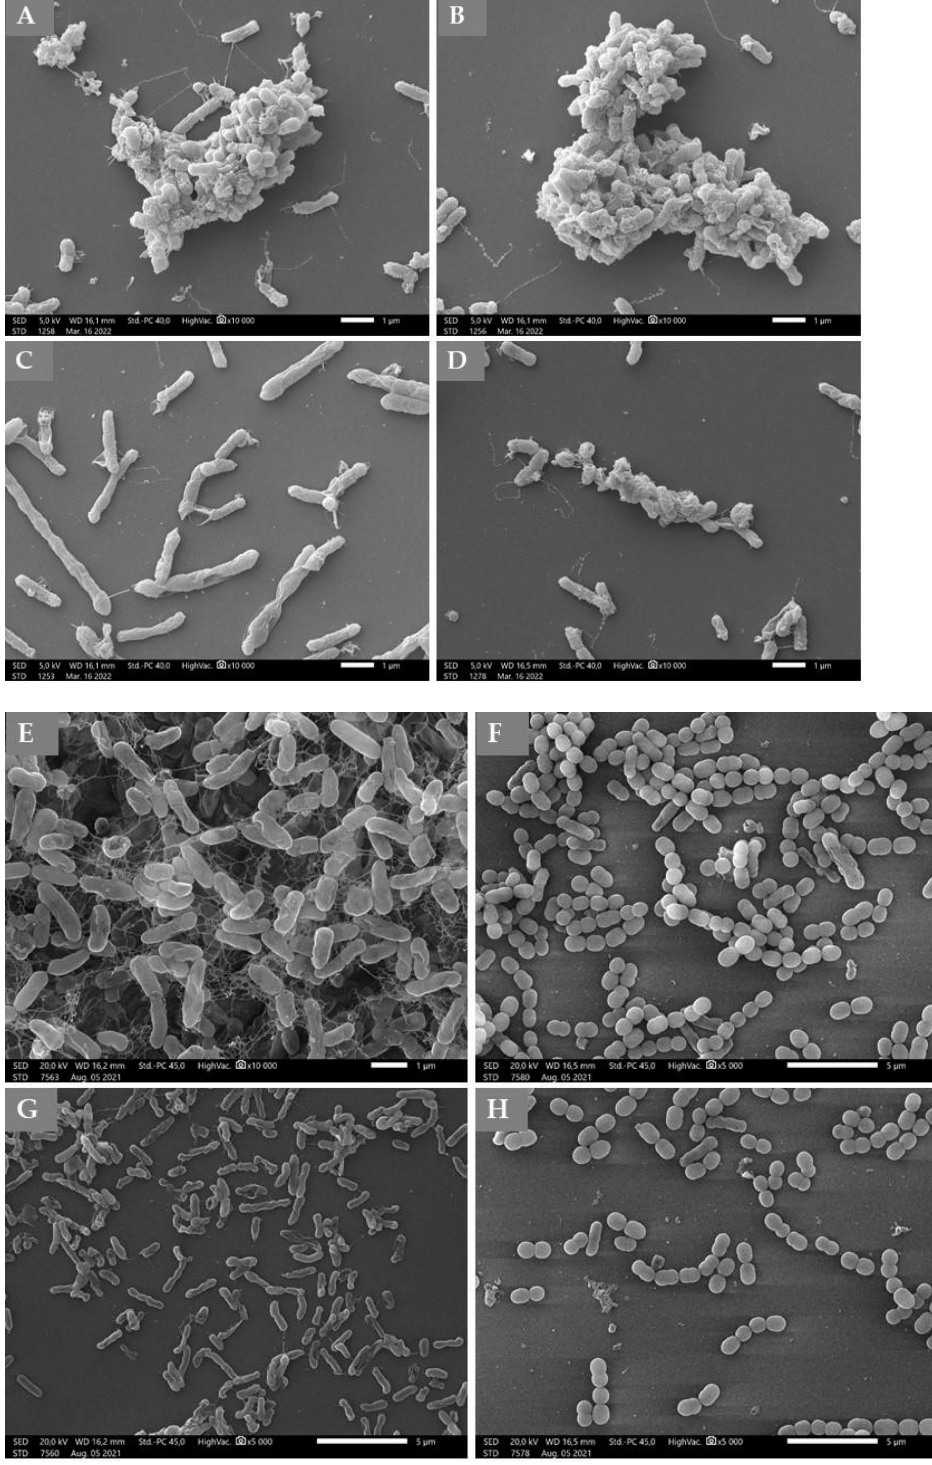
Figure 2. Scanning electron microscopic images of H. influenzae ( A , C ), H. parainfluenzae ( B , D ), P. aeruginosa ( E , G ) and S. pneumoniae ( F , H ) biofilms. ( A , B , E , F ): Control samples of bacterial strains: ( A )— H. influenzae , ( B )— H. parainfluenzae , ( E )— P. aeruginosa , ( F )— S. pneumoniae . ( C , D , G , H ): Treated bacterial biofilms by Tween40 emulsion of immortelle EO: ( C )— H. influenzae , ( D )— H. parainfluenzae , ( G )— P. aeruginosa , ( H )— S. pneumoniae . Immortelle EO was used in MIC/2 concentration .